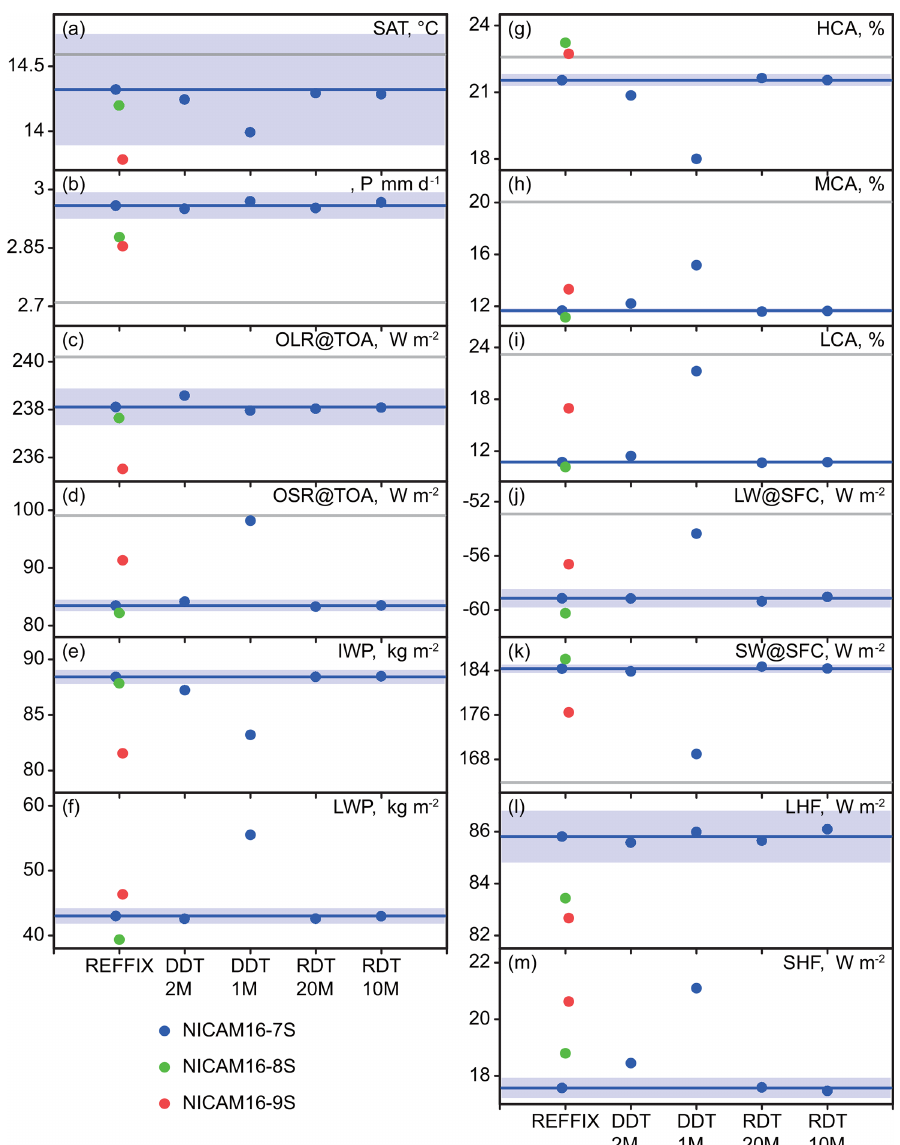
Figure 16. Same as the left part of Fig. 5 but for the REFFIX, DDT2M, DDT1M, RDT20M, and RDT10M